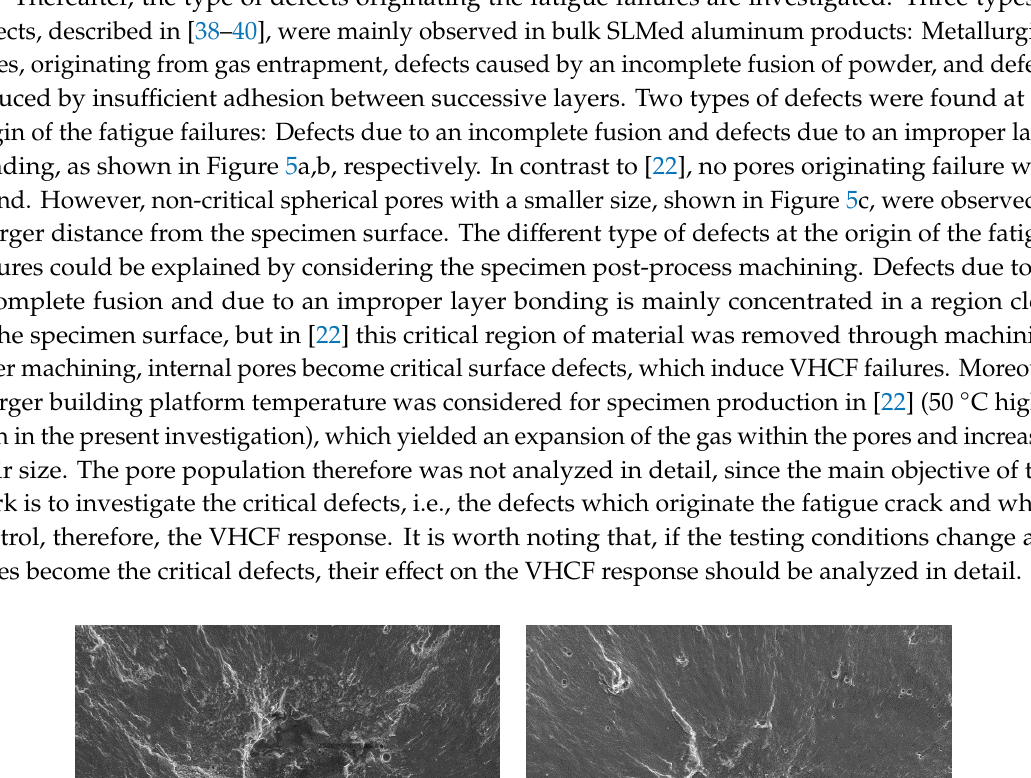
Figure 4. Distribution of defects along the longitudinal and radial directions.